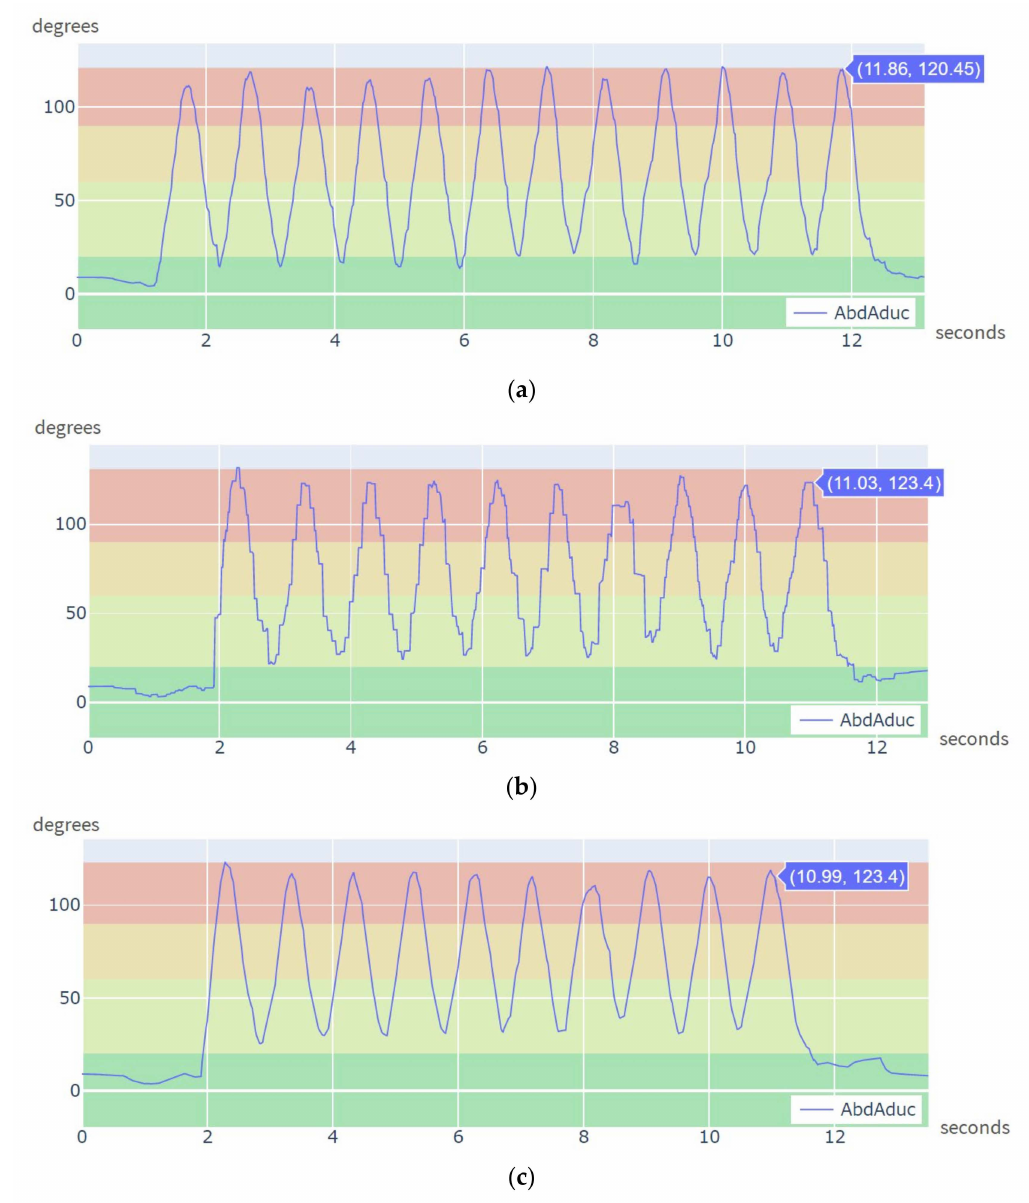
Figure 12. Left shoulder abduction/adduction angle during half jacks exercise: ( a ) Computed from raw-data using 10 CW sensors; ( b ) Computed from raw data using 12 CW sensors; ( c ) Same as ( b ) after spherical linear interpolation of acquired